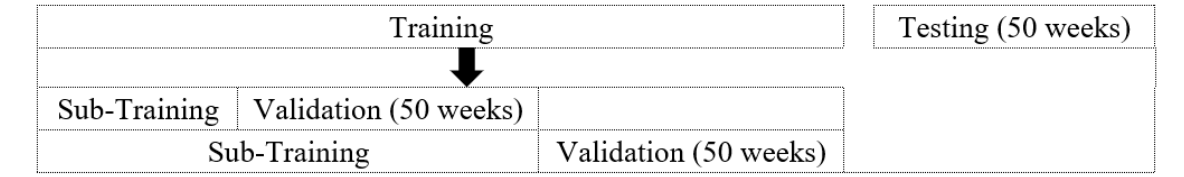
Figure 1. The 2-fold time-series cross-validation for daily models.